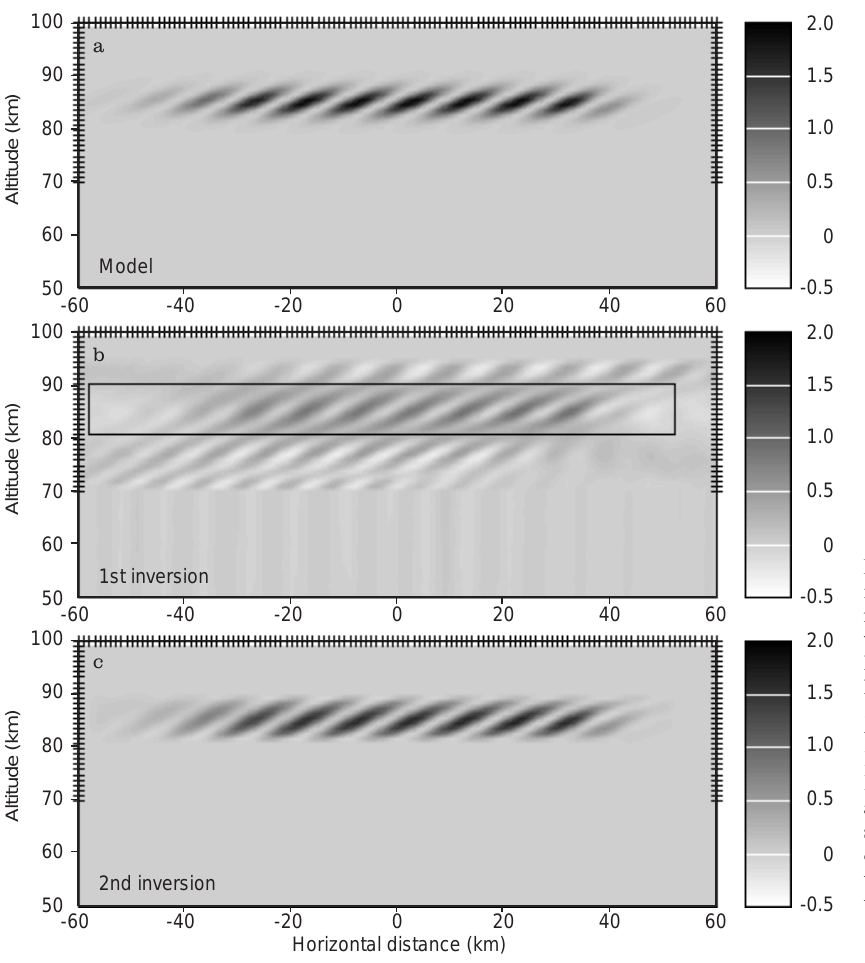
Fig. 3. a Model of airglow volume emission rate indicating a short-scale gravity wave. The model contains a Gaussian vertical profile with a scale length of 2.5 km, centred at 85 km altitude and modulated by a wave with horizontal and vertical wavelengths of 10 and 5 km, respectively. Both ends of the model are tapered horizontally by Gaussian functions. b Results of the first inversion of the data in Fig. 4. The regularization box is indicated by a black line (see the text). c Results of the second inversion of the data in Fig. 4, carried out using constant non-zero regularization variances inside the box in panel b and zero